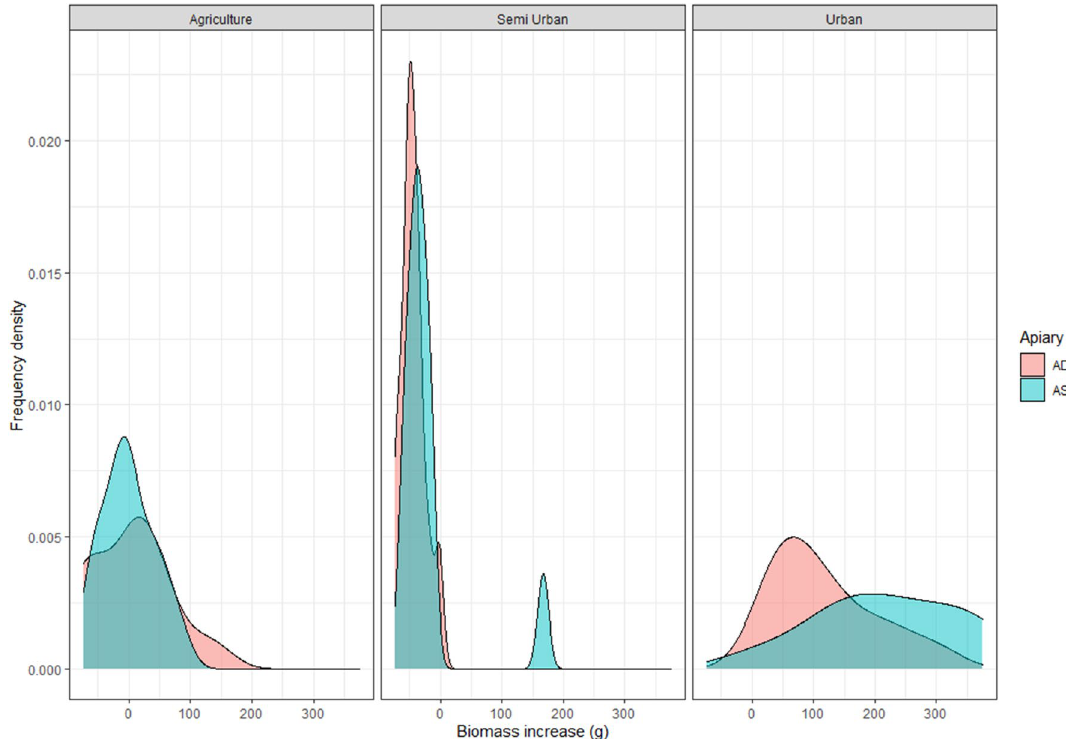
Figure 3. The frequency densities of the biomass increase of a bumble bee nests (in grams) in three different landscape types (Agriculture; Semi Urban, and Urban). The blue–green graphs represent apiary sparse (AS) sites, the red are apiary dense (AD) sites.